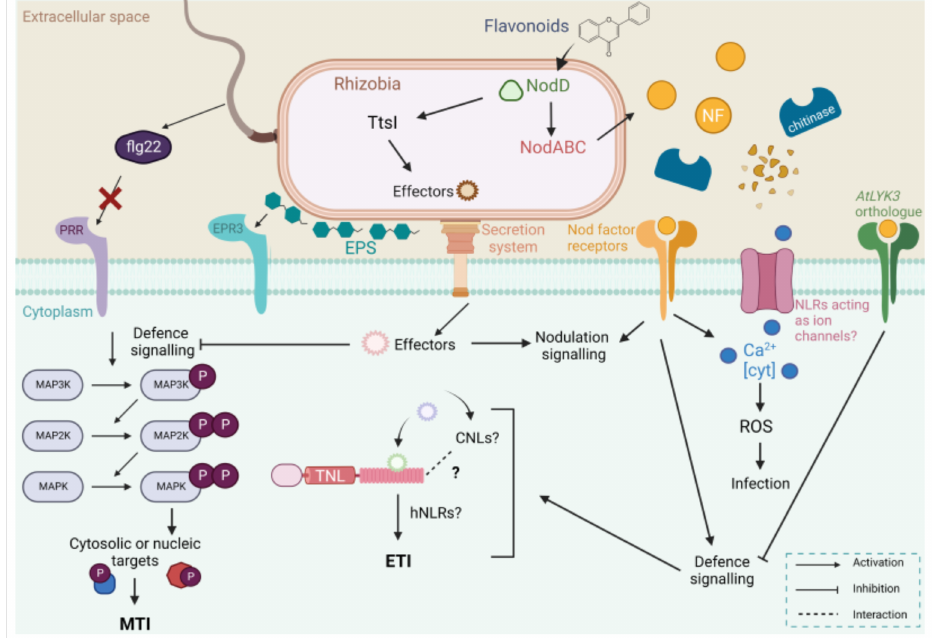
Figure 1. A general model for the interplay of nodulation and defence signalling mechanisms induced by rhizobial infection at the root hair cell. To attract rhizobial partners, legume roots exude